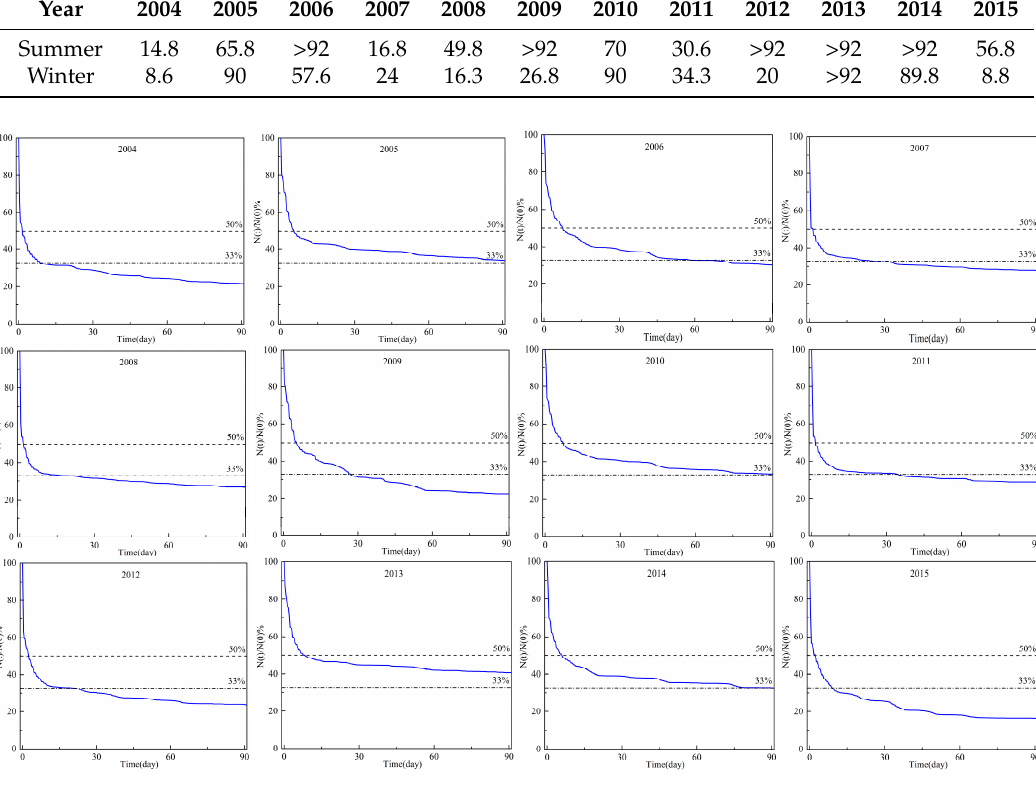
Figure 9. The number of particles remaining in the bay relative to the initial numbers in winter (2004 – 2015) .